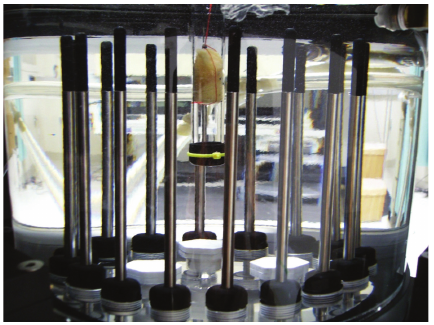
Figure 6: Microwave data acquisition of a saline-saturated bone sample in a test tube submerged in an 80% glycerin bath (side